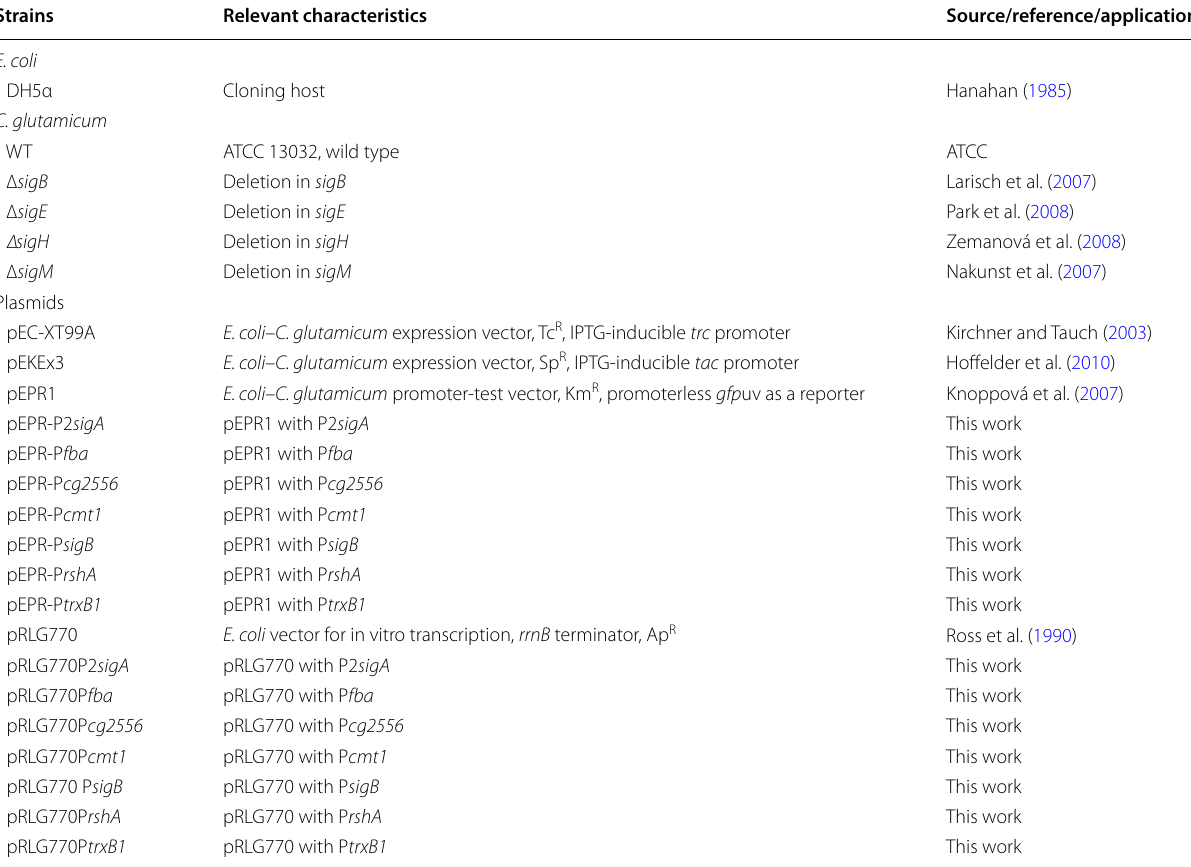
Table 1 Strains and plasmids used in this